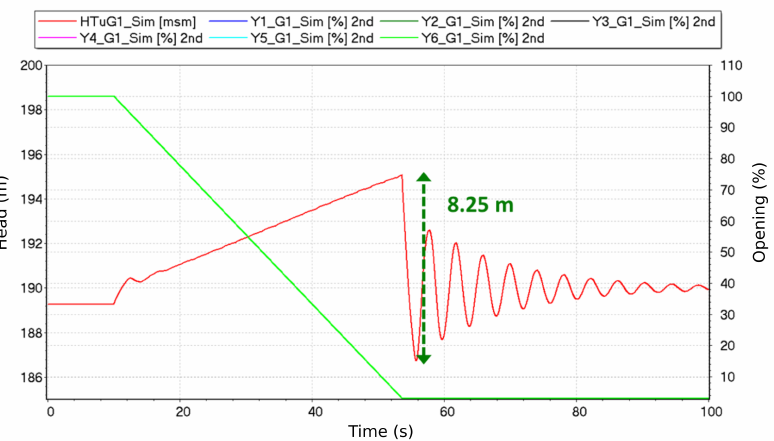
Figure 6. Simulation of an emergency shutdown at a low head around 189 m. HTuG 1_ Sim is the simulated head available for the group 1 and Y i _ G 1_ Sim is the needle stroke in % for each